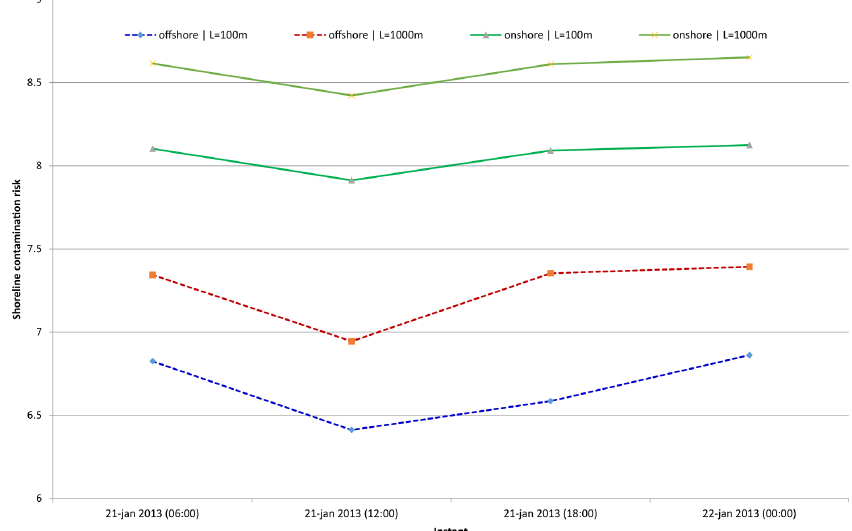
Figure 17. Integrated shoreline contamination risk levels at different time instants from 21 and 22 January 2013, under onshore and offshore wind, and using different values in parameter L (shoreline stretch extension